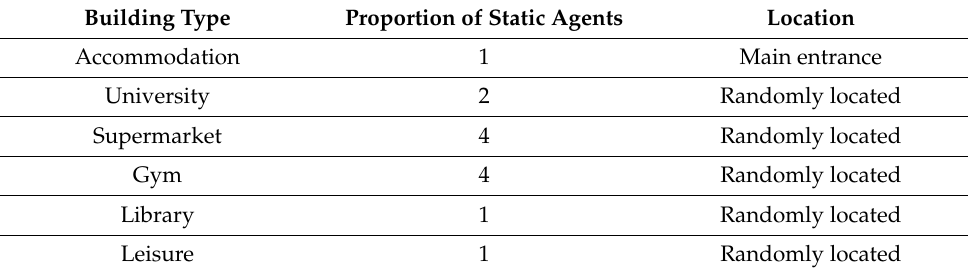
Table 4. Proportion of static agents per type of building and unit